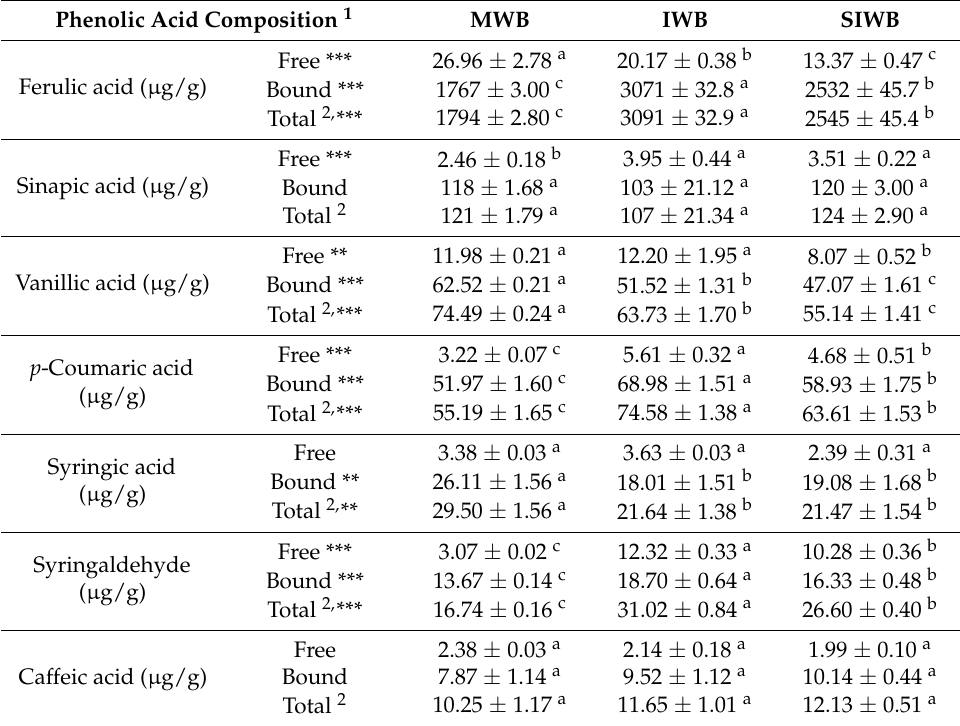
Table 1. Phenolic acid compositions in extracts of mature wheat bran (MWB), immature wheat bran (IWB), and steamed immature wheat brans